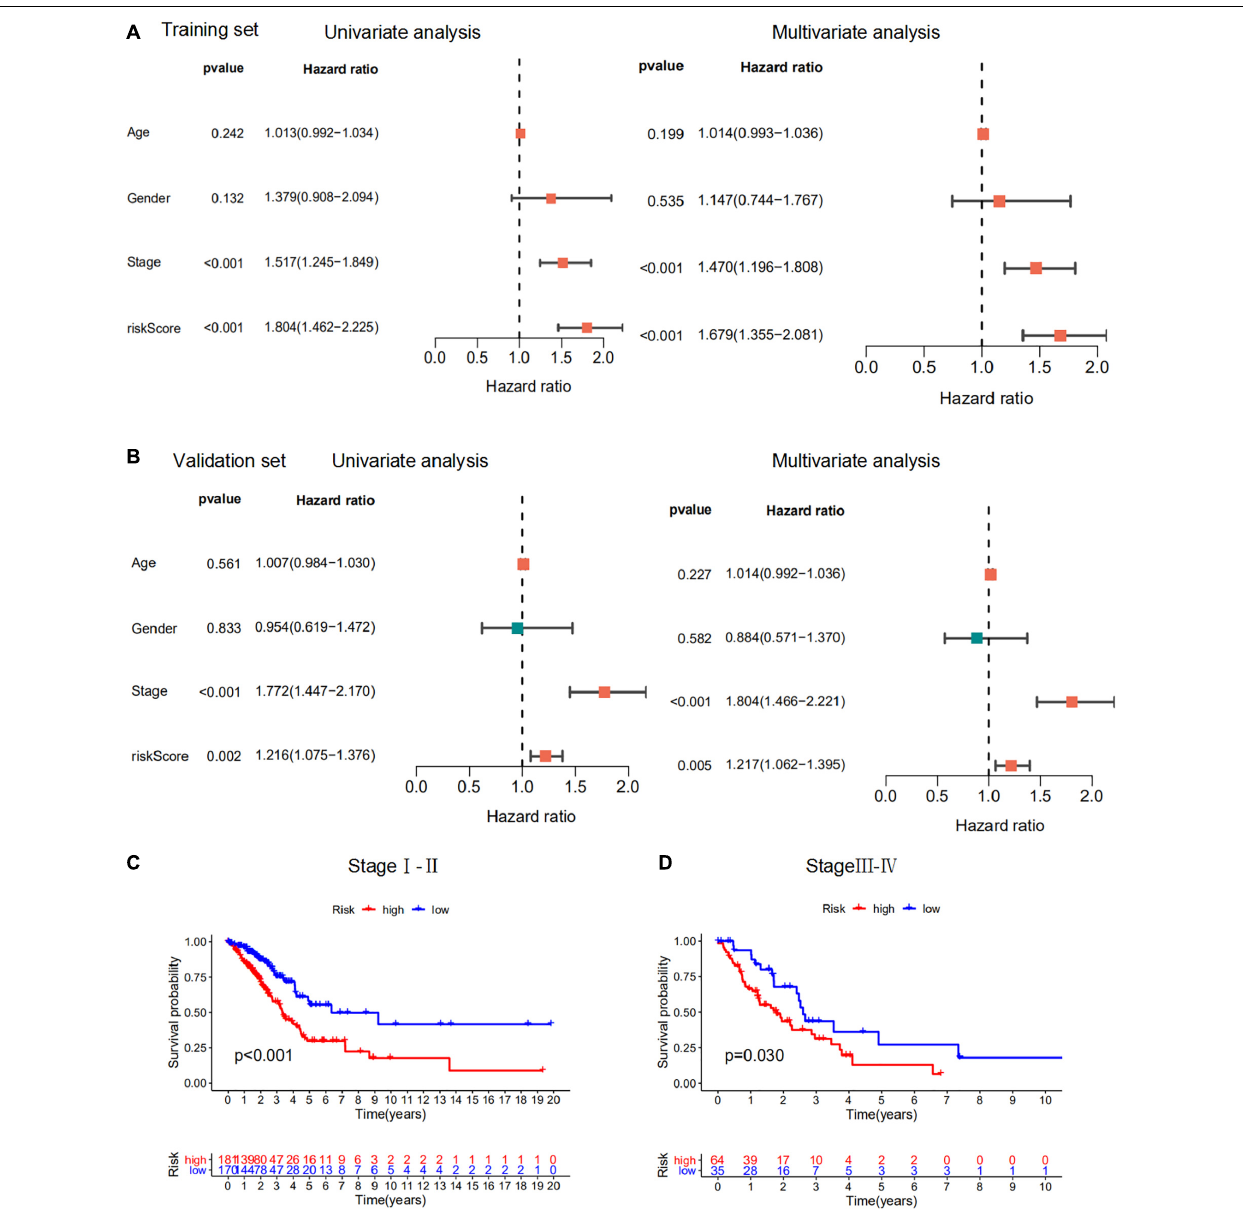
FIGURE 6 | Prognostic analysis of the m6A-RPS. (A,B) Univariate and multivariate Cox regression analysis of correlations between risk score for m6A-RPS and clinical parameters in the training set and validation set. (C,D) Kaplan–Meier survival analysis of m6A-RPS prognostic value in LUAD stage I–II and stage III–IV cases in the TCGA